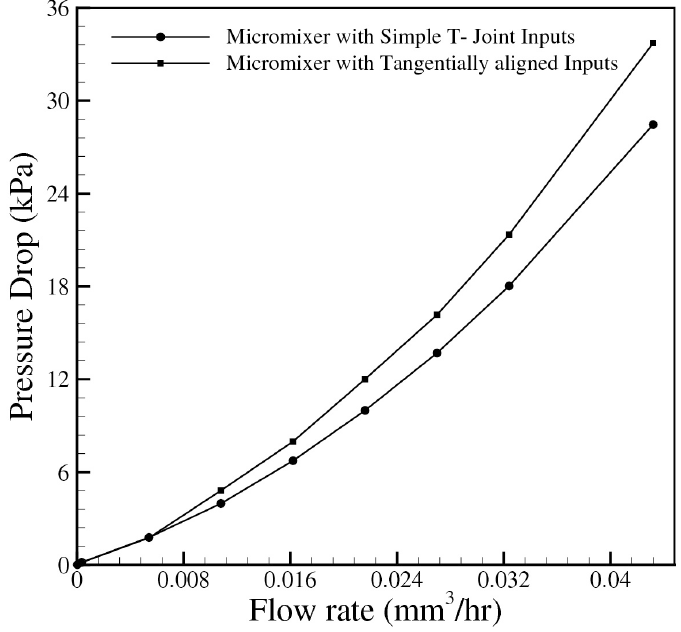
Figure 11. Variation of pressure drop with flow